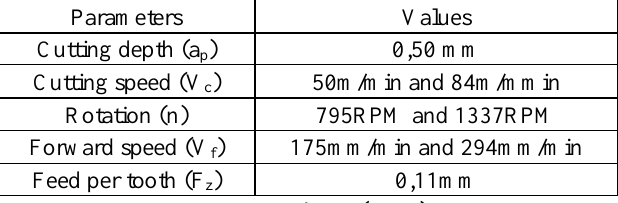
Table 4: Sample machining conditions.